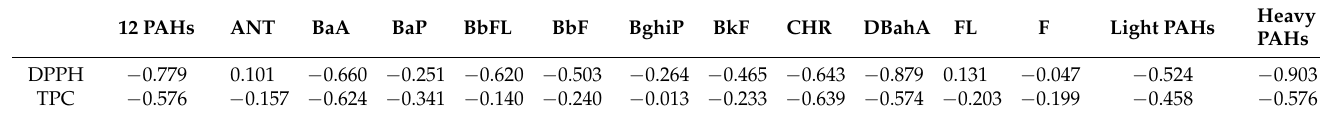
Table 8. Correlation coefficient (p) between the level of PAHs ( µ g/kg) and DPPH and